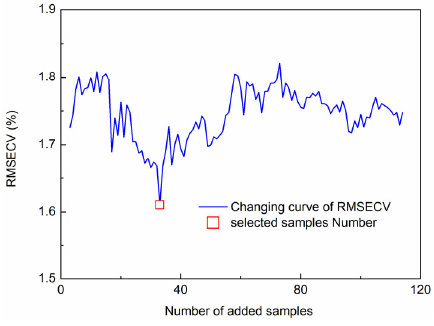
Figure 7. RMSECV distribution in different numbers of samples.